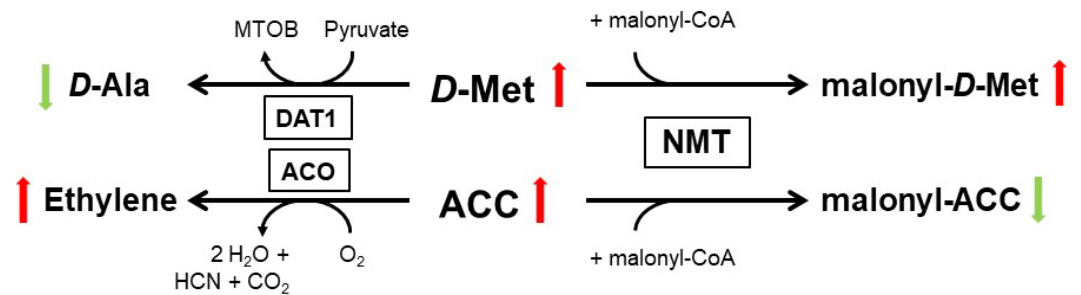
Figure 2. Major metabolic pathways of d -Met and ACC in Arabidopsis , according to [41]. Green and red colored arrows indicate the decrease and increase of both educts and their products, respectively, in the course of d -Met accumulation, as it happens in plants with loss of DAT1 activity. The ACO reaction was according to [70]. ACO—ACC oxidase;